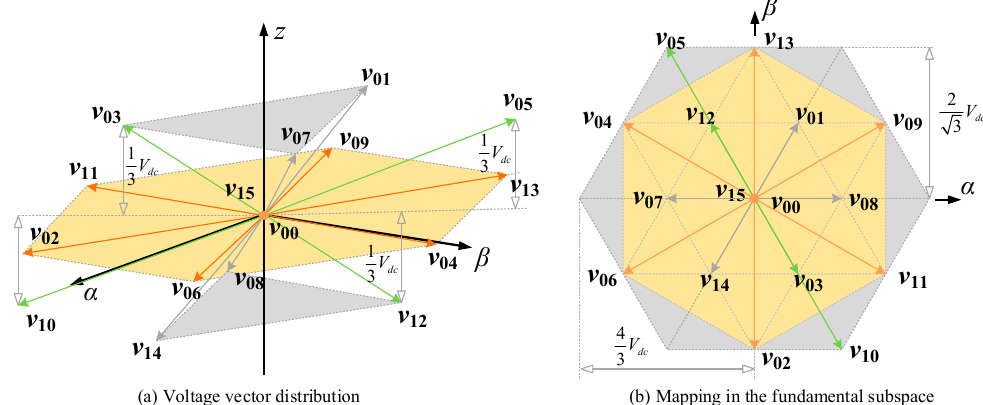
Figure 2. Voltage vectors of series-winding PMSM.